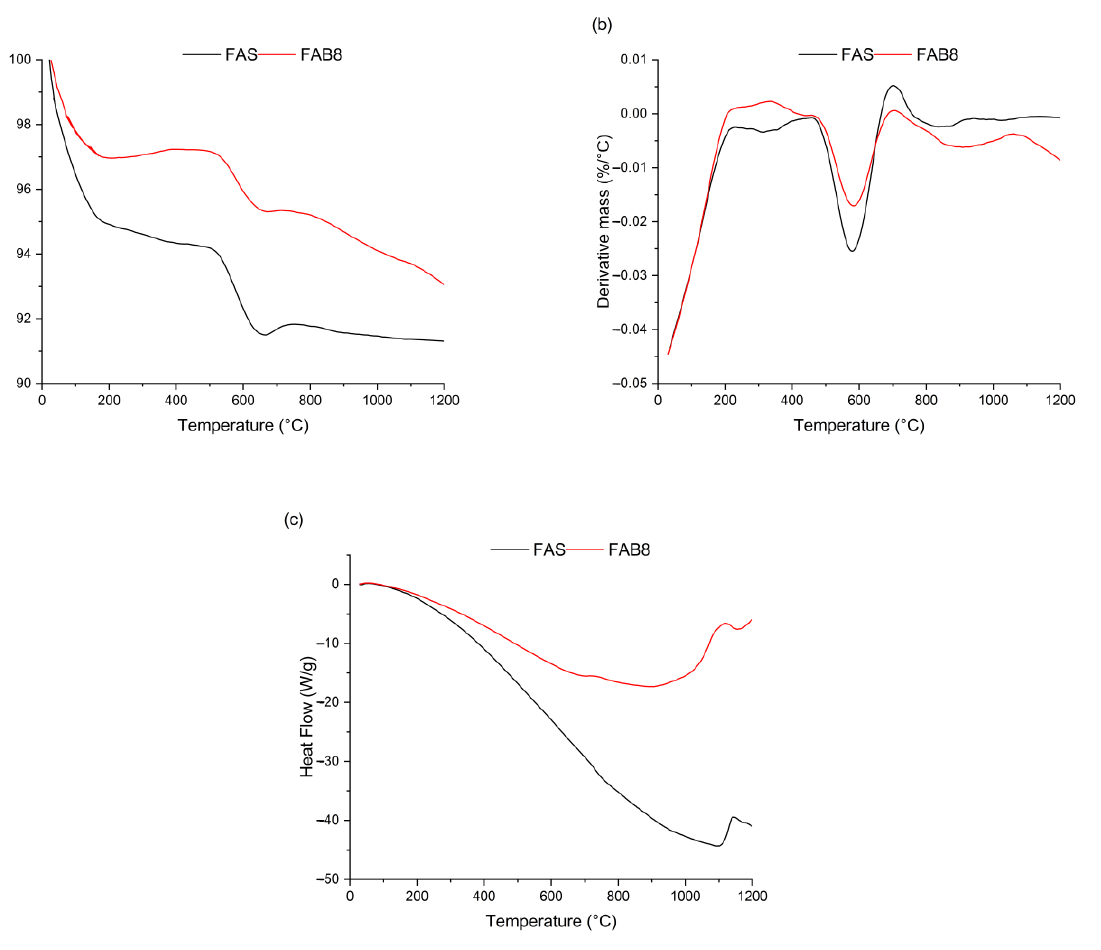
Figure 11. ( a ) TGA, ( b ) DTG and ( c ) DSC curves of FAS and FAB8 geopolymers. The total mass loss of FAS and FAB8 geopolymers were 8.2% and 6.9%, respectively,